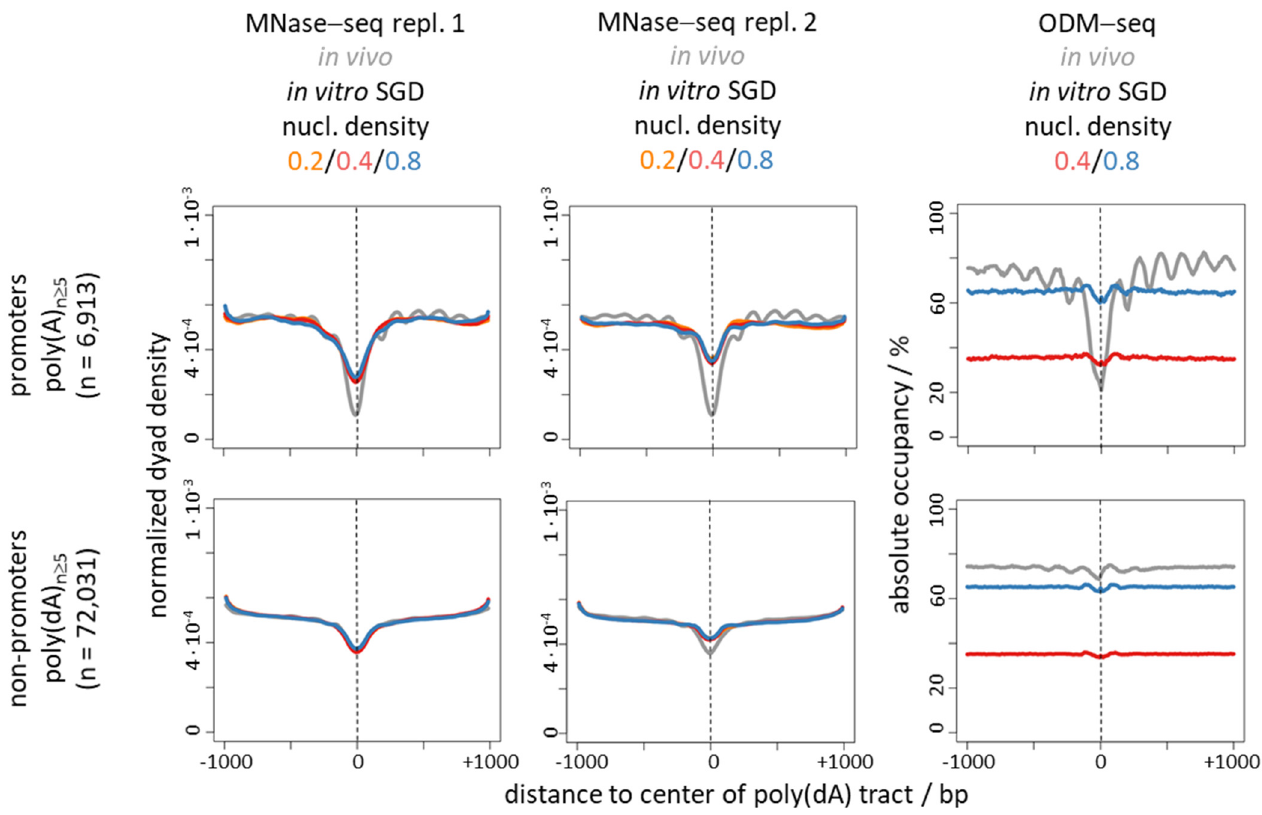
Figure 4. The difference between nucleosome depletion over poly(dA) tracts in vivo versus in vitro is much more pronounced in promoter versus non-promoter regions. Composite plots of the same data as in Figure 3, but aligned at all poly(dA) tracts ≥ 5 bp long within or outside of promoter NFRs [16]. Number (n) of instances is indicated. Strand orientation was taken into account by flipping the orientation for poly(dA) tracts on the opposite strand. Vertical dashed lines mark the alignment points.